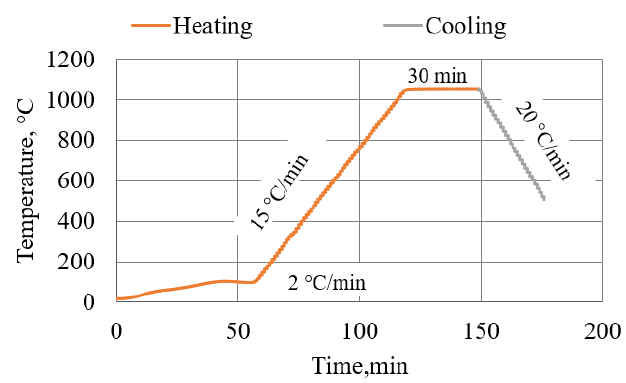
Figure 3. Heating profile used for the carbonization of carbonaceous materials in the TGA tests.